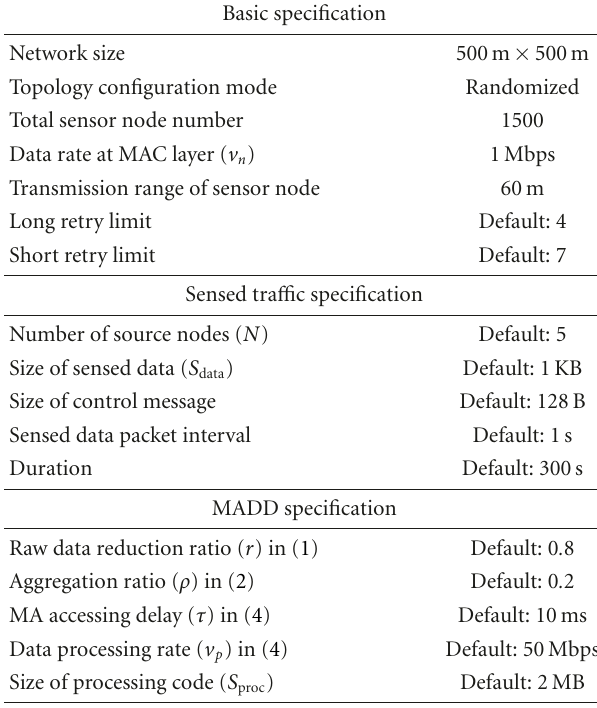
Table 2: Simulation